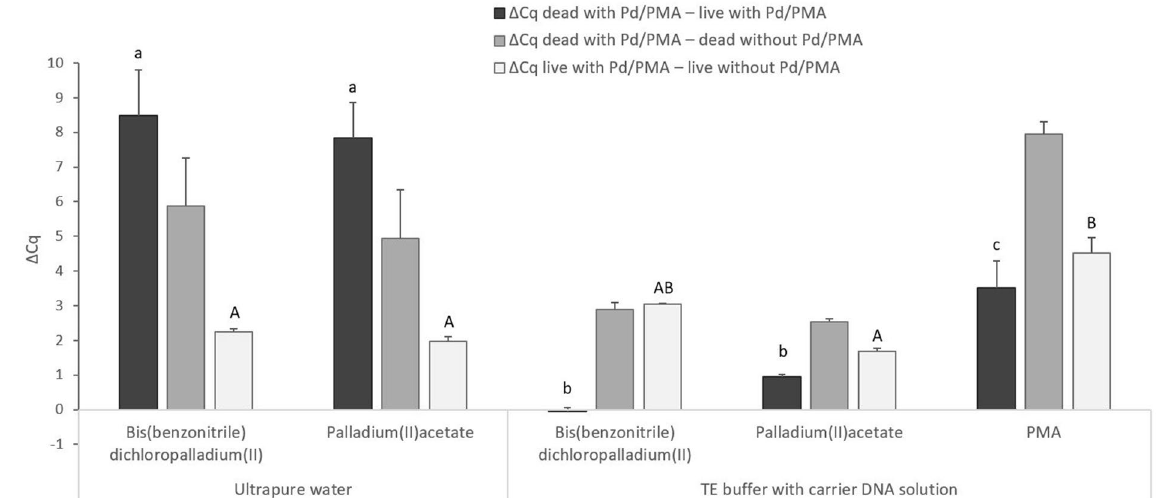
Figure 4. Comparison of treatment of MAP cells with bis(benzonitrile)dichloropalladium(II), palladium(II) acetate and PMA, and the effect of two different resuspension media (ultrapure water, TE buffer with carrier DNA solution) used after the Pd treatment. The ΔCq values represent the individual mean differences of Cq values counted from four biological and technical replicates. Two-way ANOVA with factors of agents used and resuspension medium and Tukey´s HSD test were used to evaluate the significance of differences between ΔCq. Identical letters signify statistically insignificant differences (P > 0.05) between ΔCq values, and different letters signify significant differences (P < 0.05). The values of ΔCq dead with Pd/PMA – live with Pd/PMA were labeled with lowercase letters, and the values of ΔCq live with Pd/PMA – live without Pd/PMA were labeled with capital letters, since they were assessed separately. Error bars express standard deviations counted from four